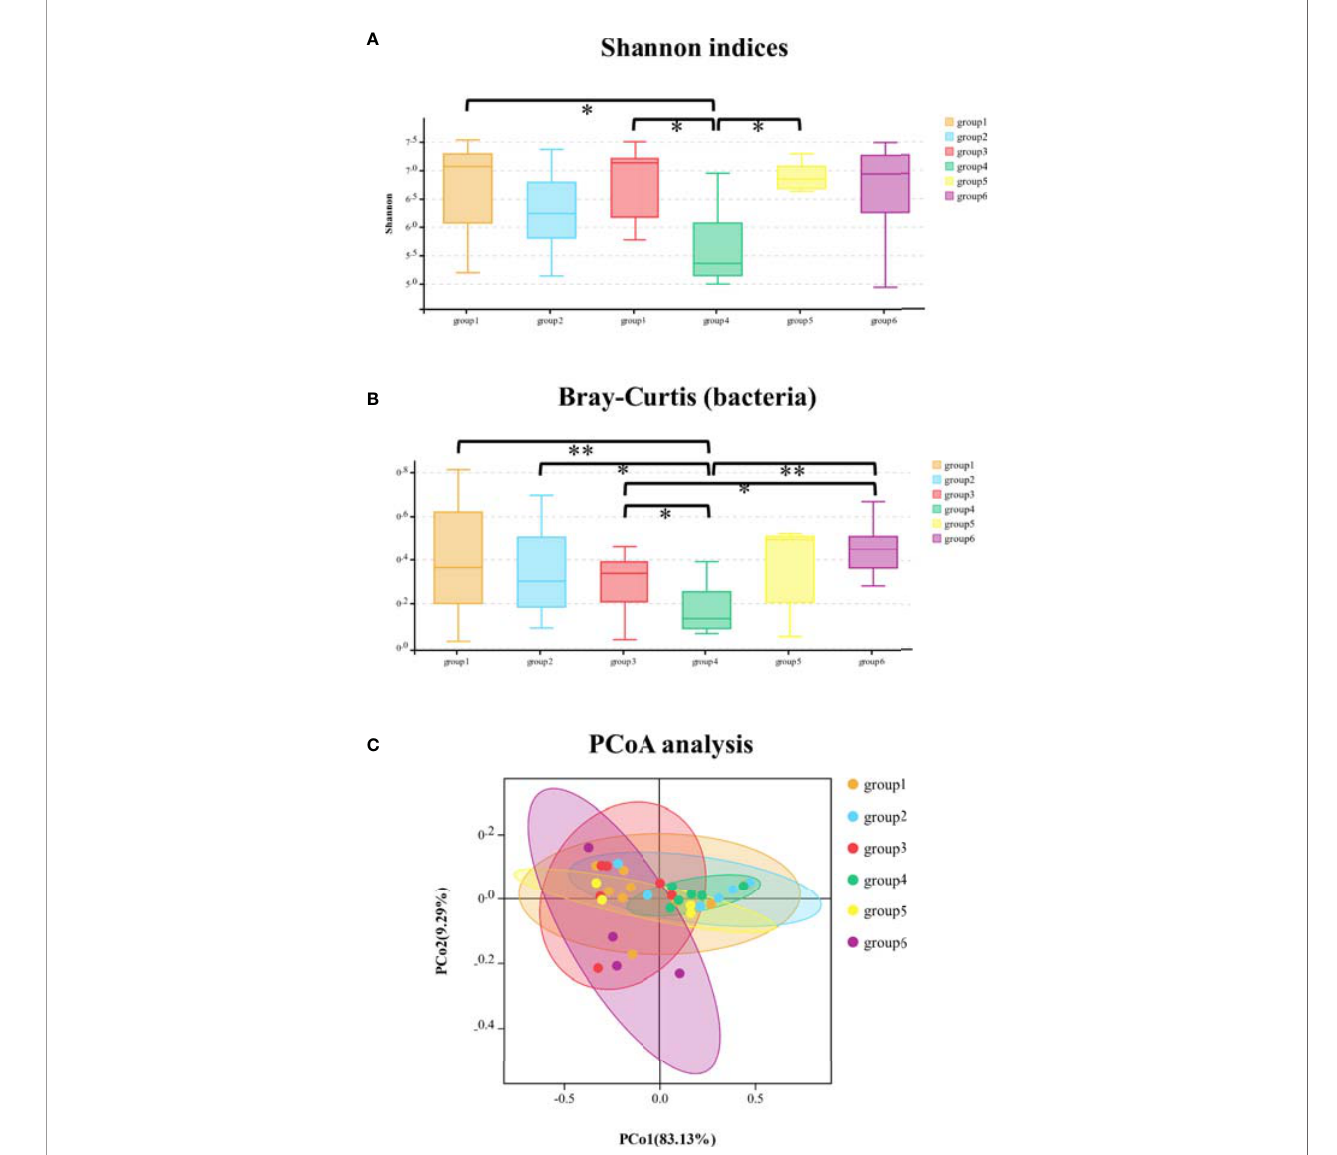
FIGURE 2 | The comparison of Shannon indices of bacterial community among six groups at phylum level (A) ; the comparison of Bray – Curtis distance of bacterial community among six groups at class level (B) ; principal co-ordinates analysis (PCoA) of bacterial community among the six groups of samples (C) . *signi fi cant at p < 0.05, **signi fi cant at p <